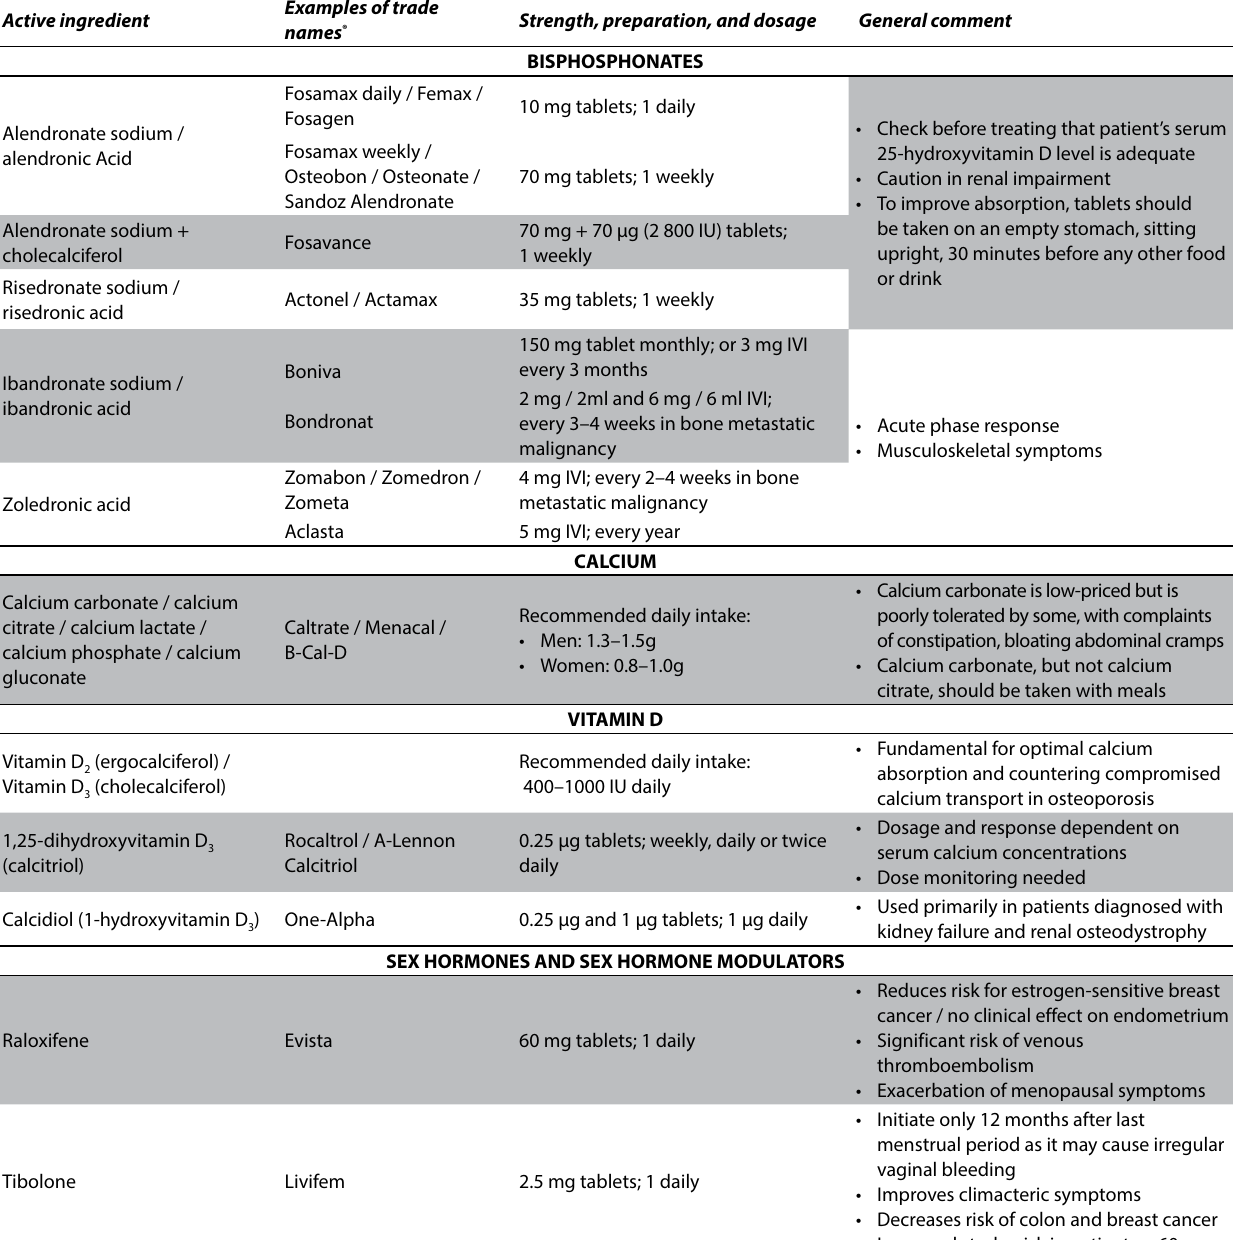
Table 3: Currently available pharmacotherapeutic agents for the prevention and treatment of osteoporosis in South Africa Active